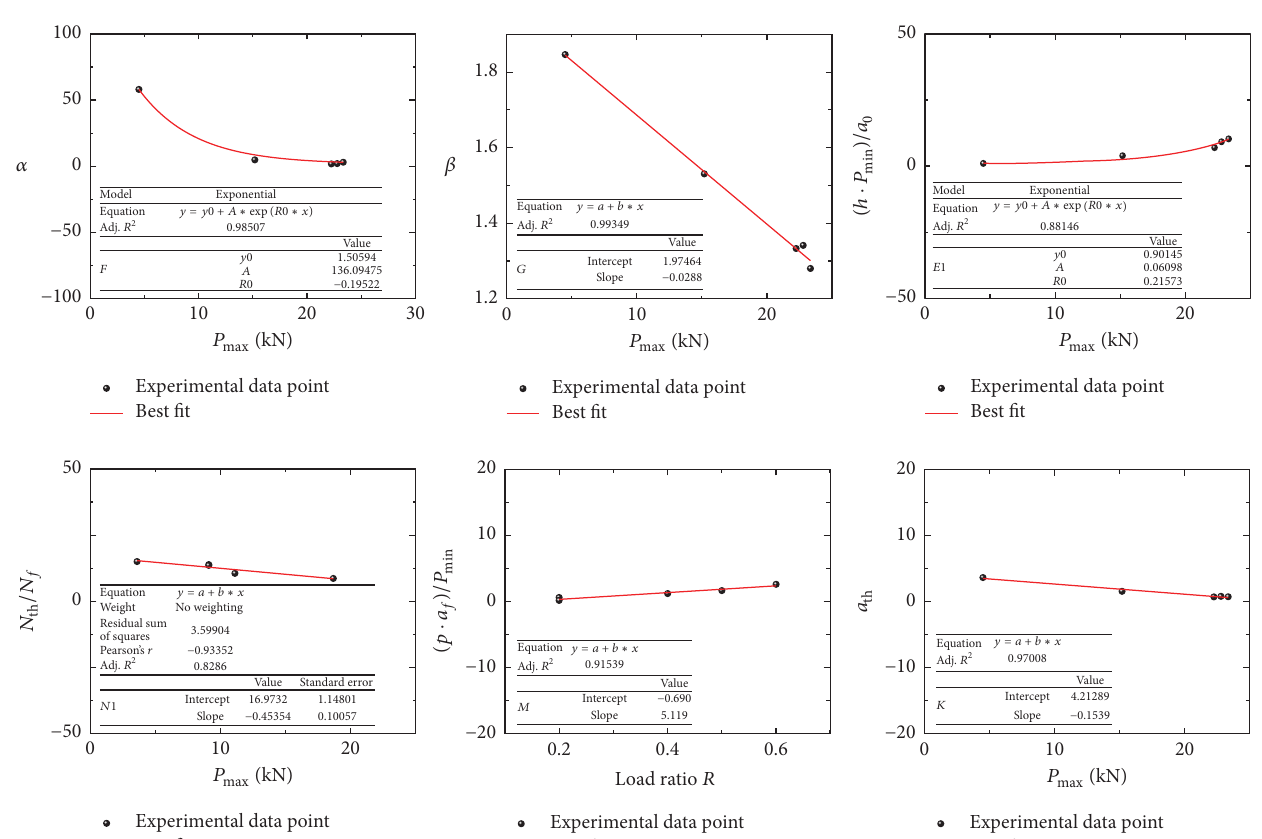
Figure 8: Best fit of the model parameters values in function of loading